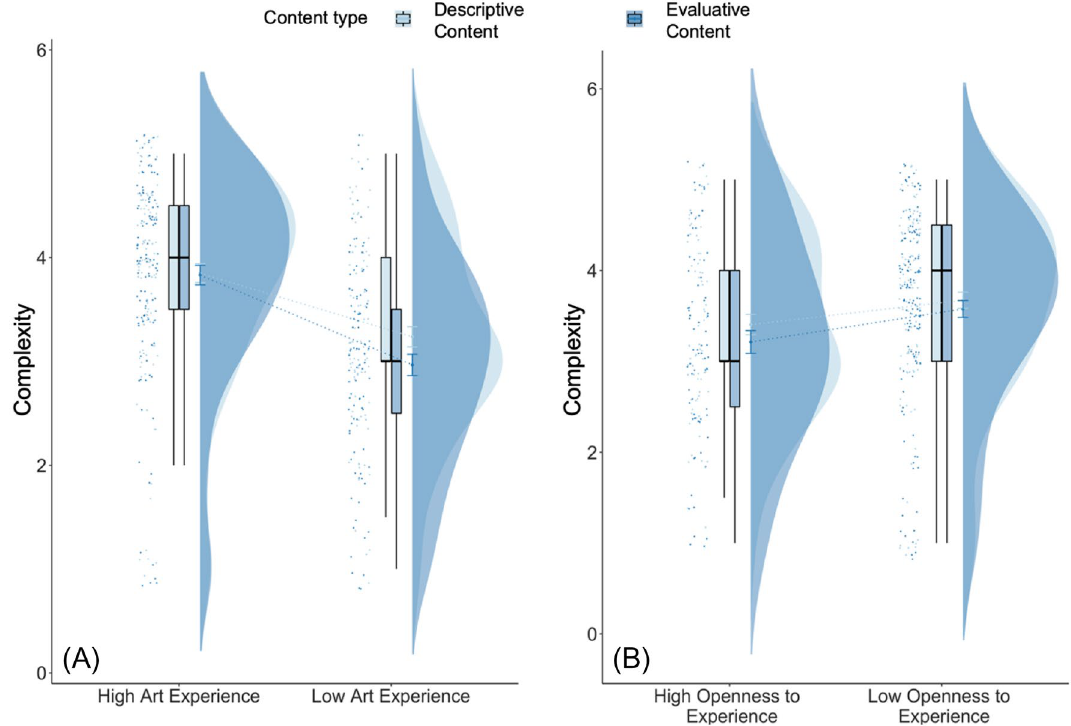
Figure 5. Complexity ratings when participants read either descriptive (in light blue) or elaborative (in dark blue) information prior to rating the artworks for participants with high and low art experience ( A ) and participants with high and low openness to experience ( B